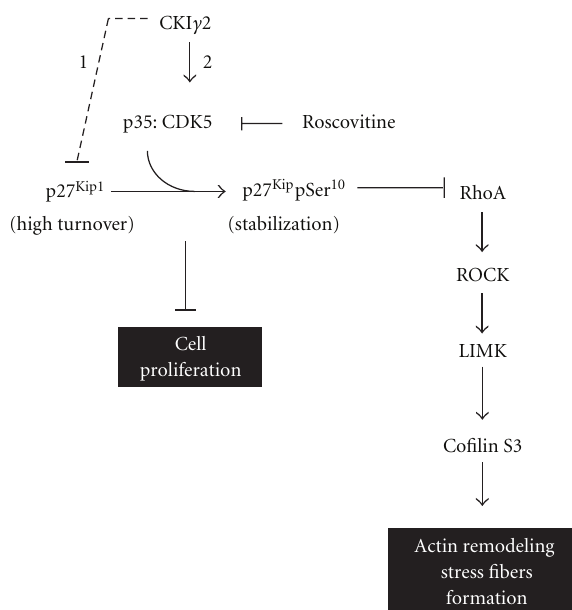
Figure 13: Model describing how CKI γ 2 prevents the formation of actin stress fibers and regulates cell proliferation. Overexpression of CKI γ 2 activates Cdk5, which contributes to p27 Kip1 stabiliza- tion and cytoplasmic accumulation following phosphorylation of p27 Kip1 at Ser 10 . Increased cytoplasmic level of p27 Kip1 correlates with decreased cellular levels of RhoA. p27 Kip1 also inhibits RhoA activation by directly binding to RhoA and competing RhoA interaction with RhoGEFs. Reduced RhoA signaling then results in decreased formation of stress fibers. Roscovitine rescues RhoA activation and signaling by inhibiting CKI γ 2-induced activation of Cdk5 therefore prevents p27 Kip1 phosphorylation at Ser 10 and promotes p27 Kip1 degradation. (1) indicates CKI γ 2 kinase- independent, while (2) represents CKI γ 2